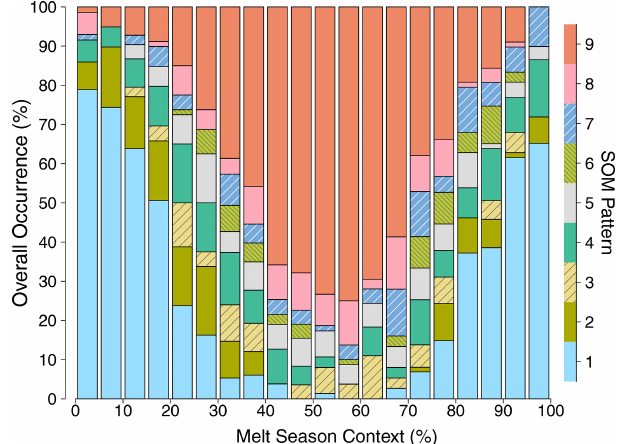
Figure 4. Day-to-day progressions between the nine melt patterns. The colours indicate how frequently a pattern on the x axis devel- ops into a pattern on the y axis the following day, highlighting the strong tendency for any pattern to persist until at least the next day. White squares indicate that the progression is never observed.